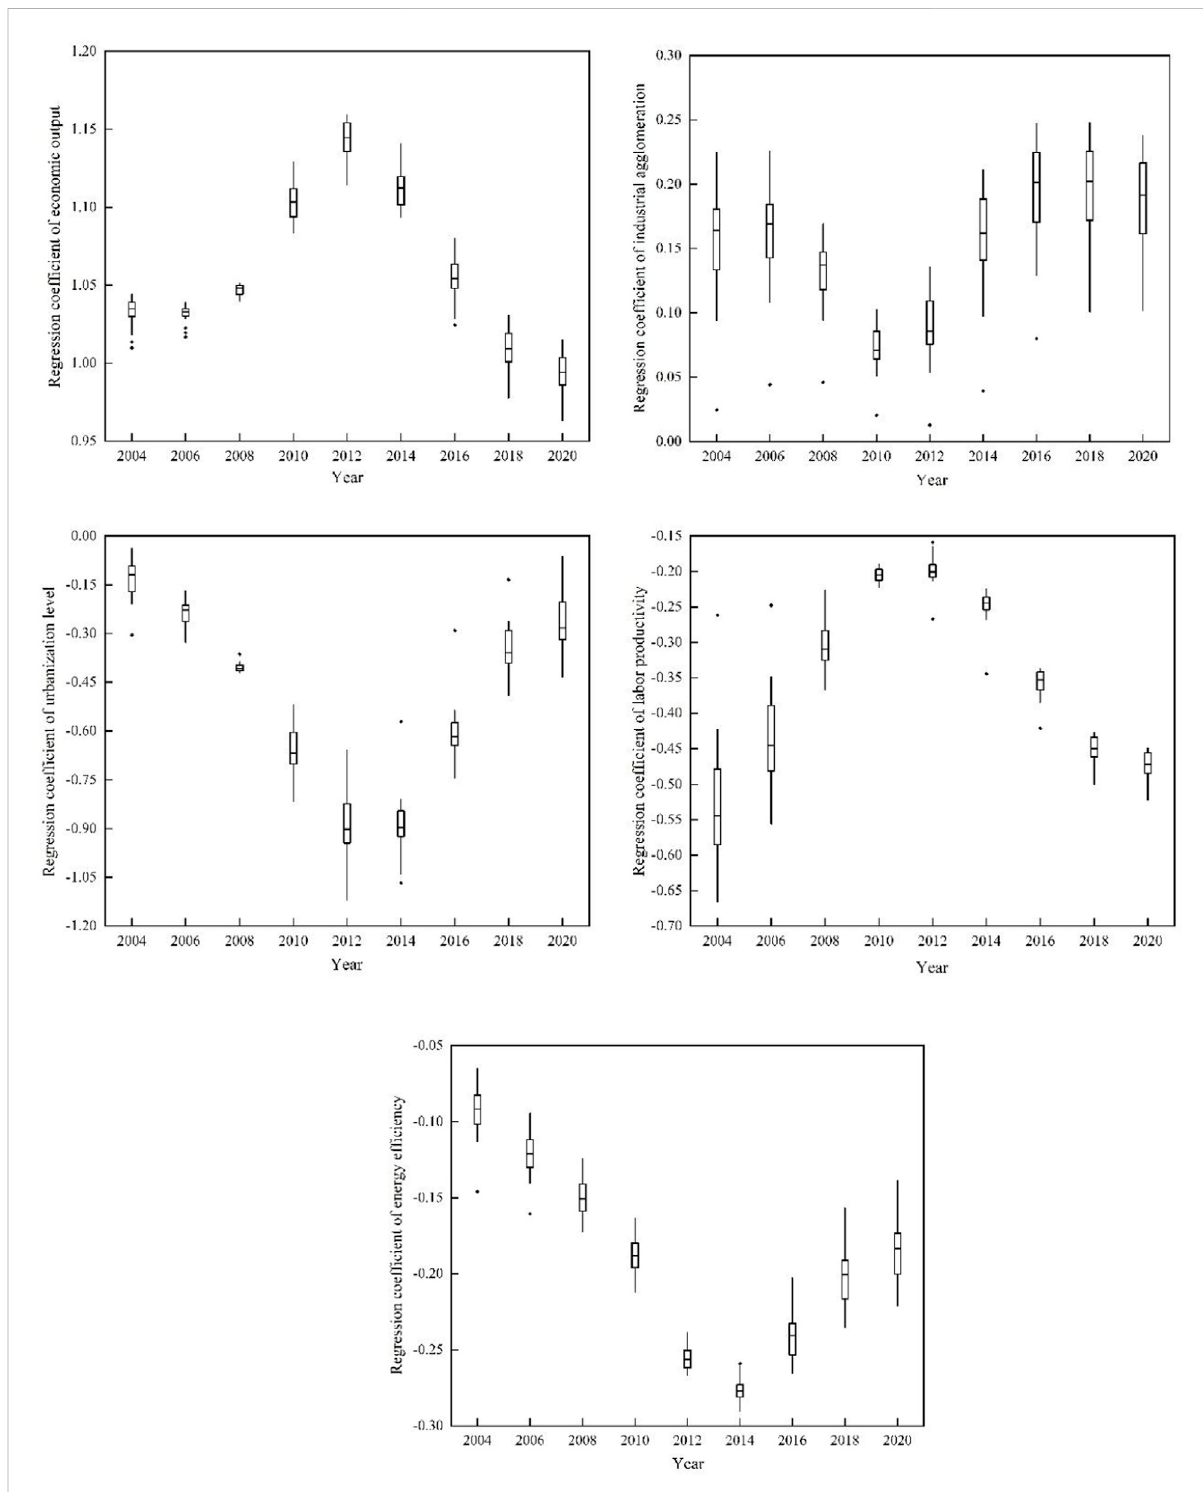
FIGURE 3 Time series trend of GTWR regression coef fi